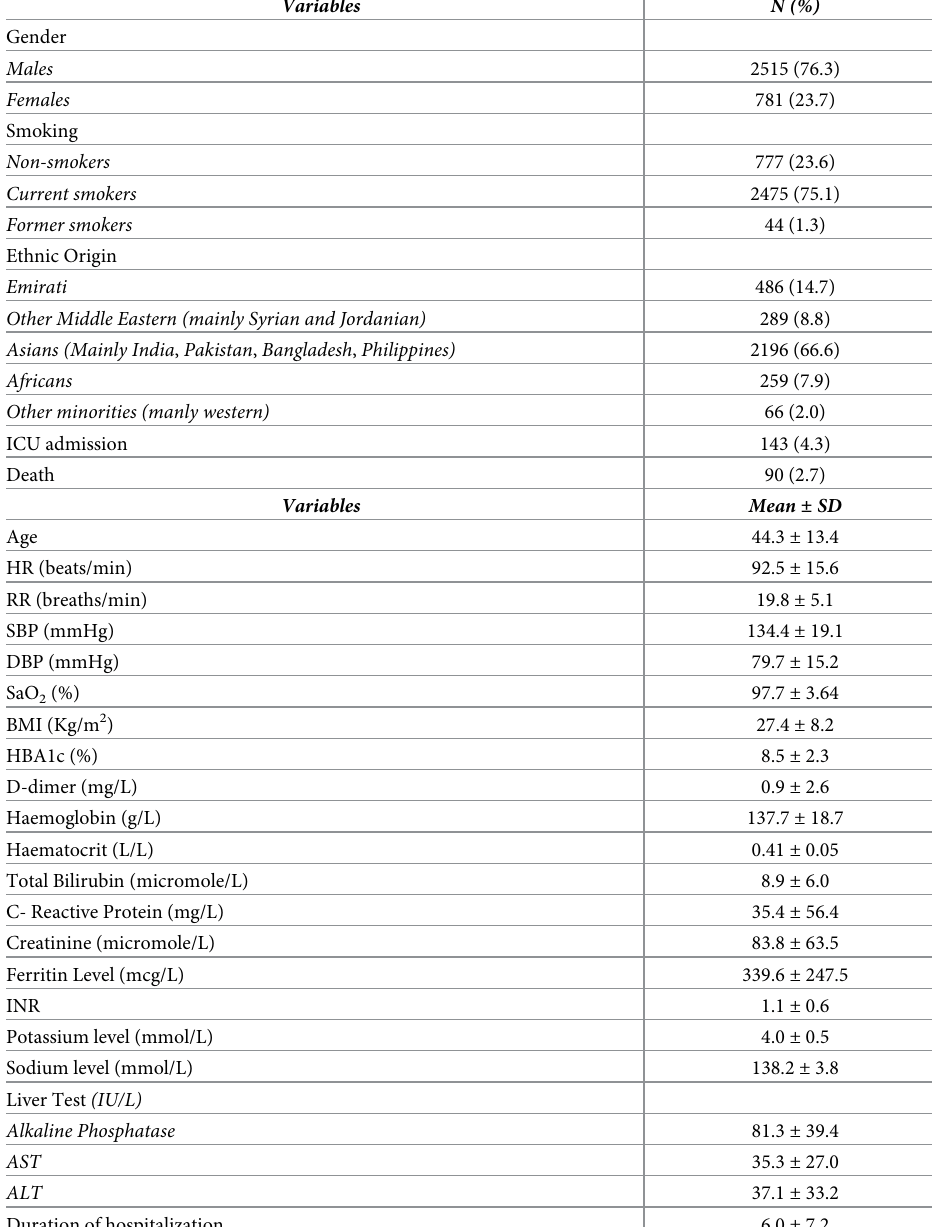
Table 1. Demographics and clinical characteristics of the patients (N =